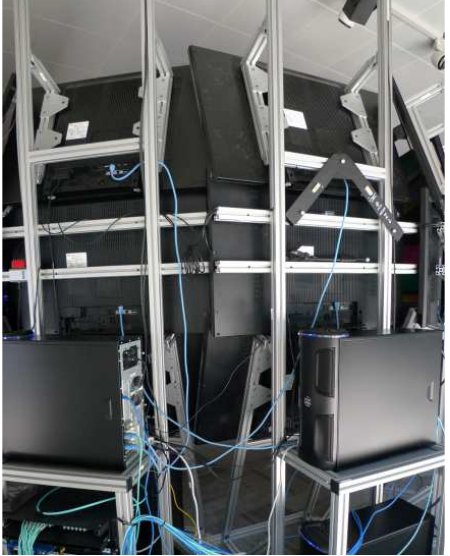
Figure 14. The back side of the KAUST NexCAVE. Photo: Tom De- Fanti.